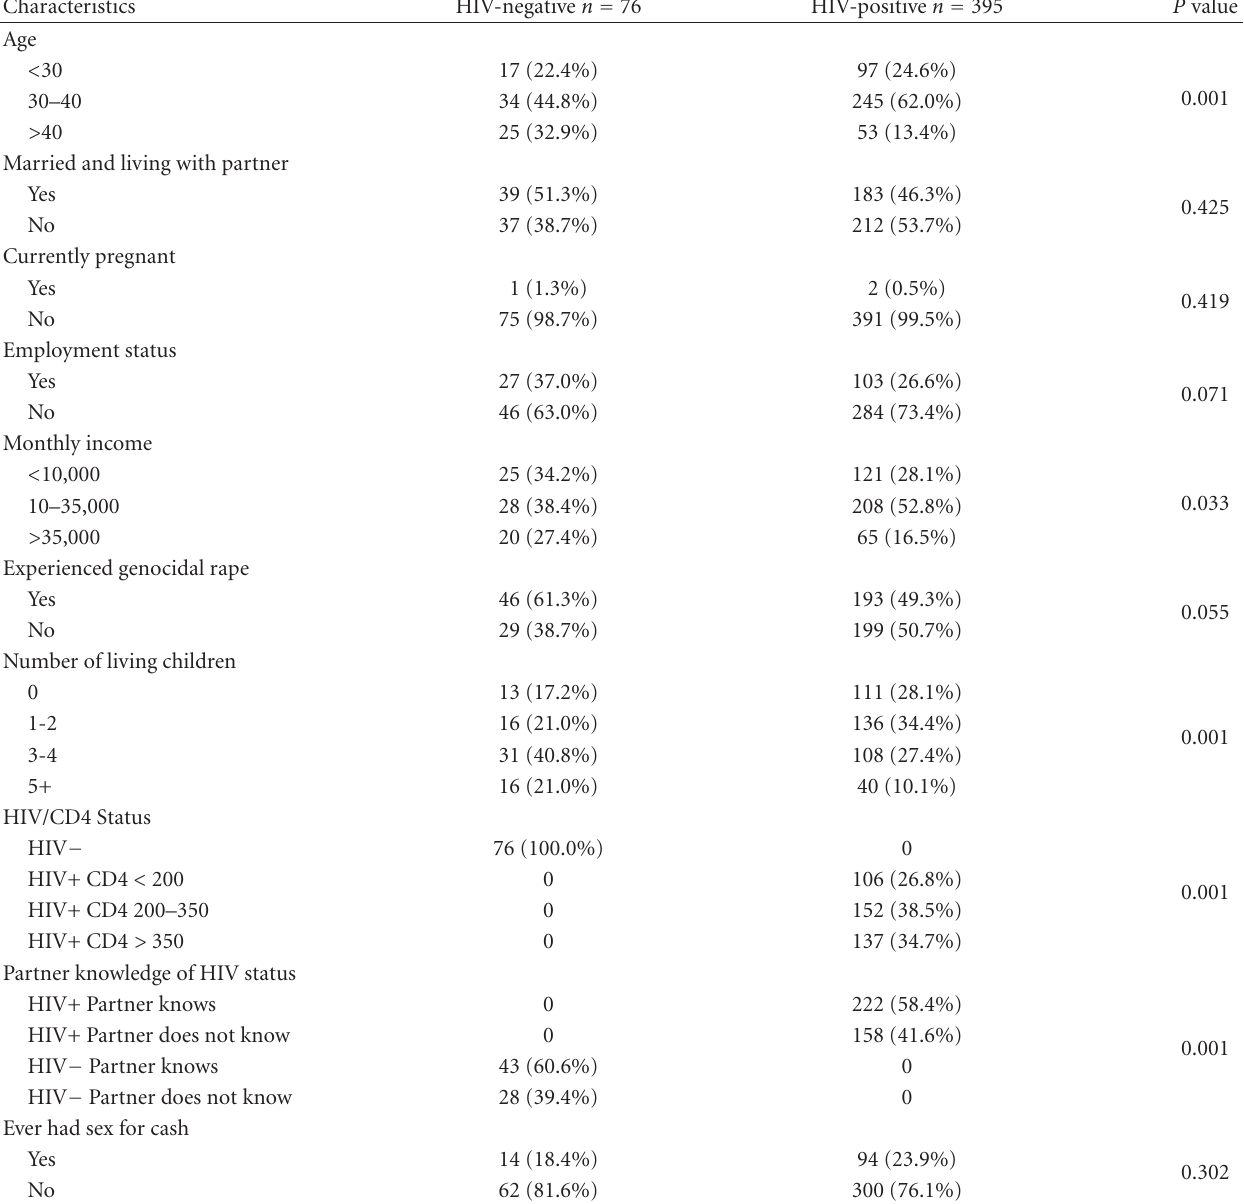
Table 1: Demographic and clinical characteristics of 471 women who reported wanting to prevent